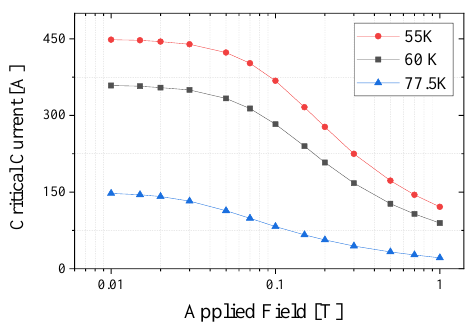
Figure 3. Critical current of PA1212 2G HTS tape under vertical fields.